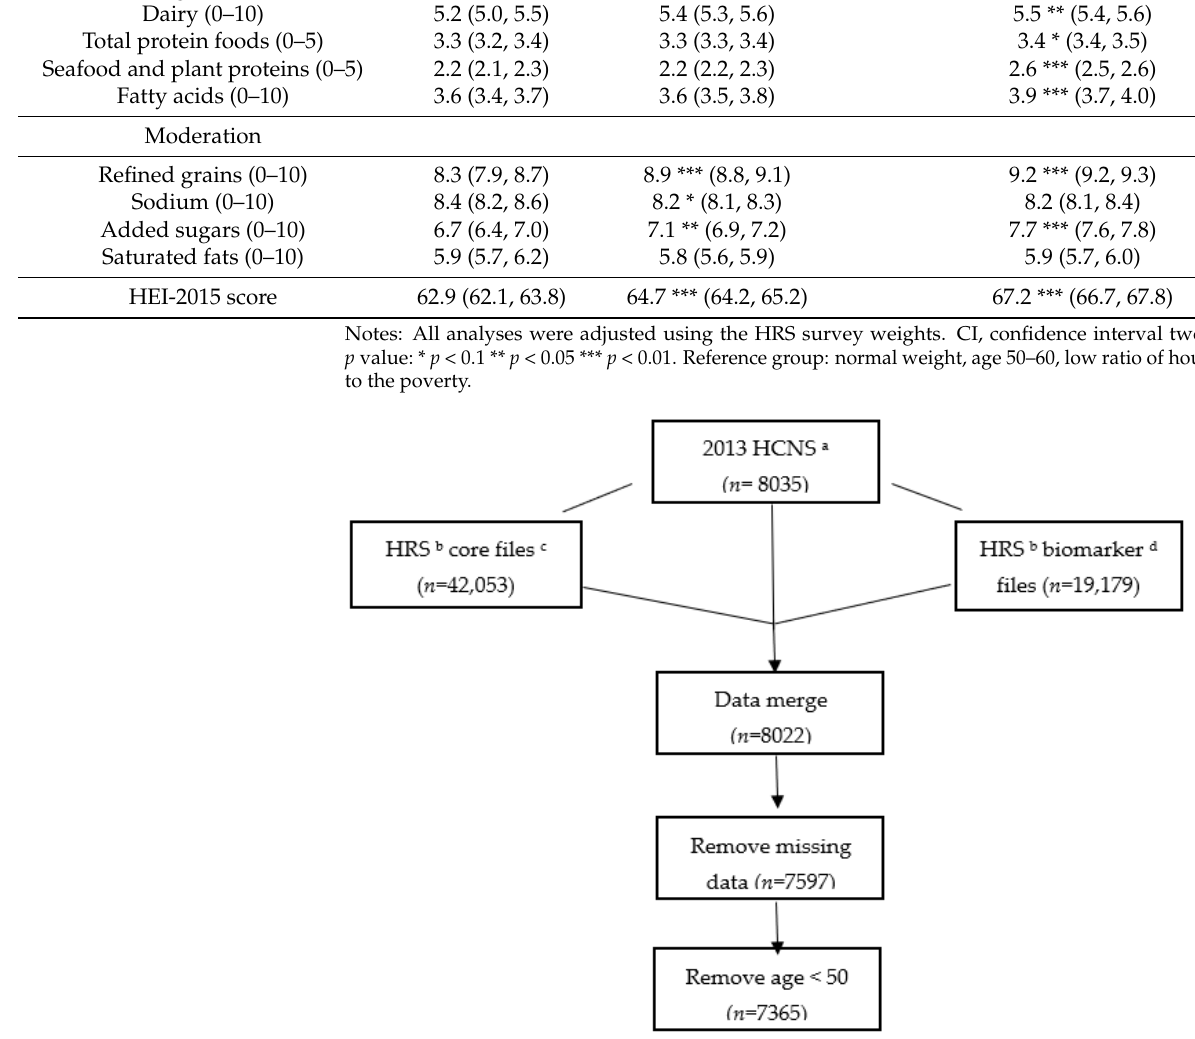
Figure A1. Dataset frame. a : 2013 Health Care and Nutrition Study (HCNS); b : Health and Retirement Study (HRS); c : HRS core files include data from year 2012 and 2014; d : HRS biomarker files include 2010, 2012, 2014, and 2016 HRS biomarker datasets. Table A1. Healthy Eating Index–2015 (HEI-2015) and component scores.